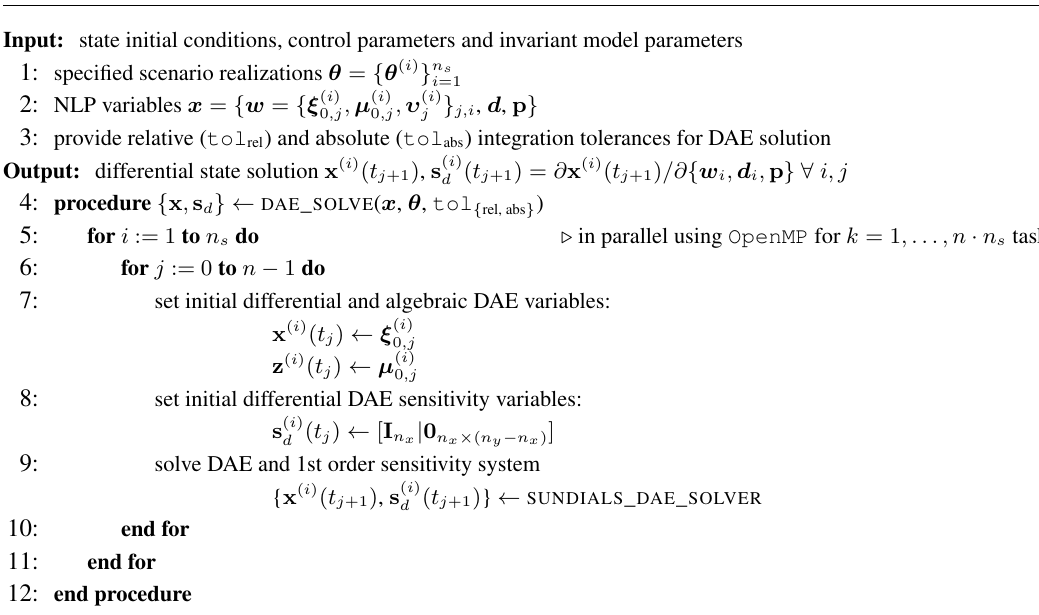
Algorithm 2 computes the solution of the discretized relaxed embedded DAE (both state and